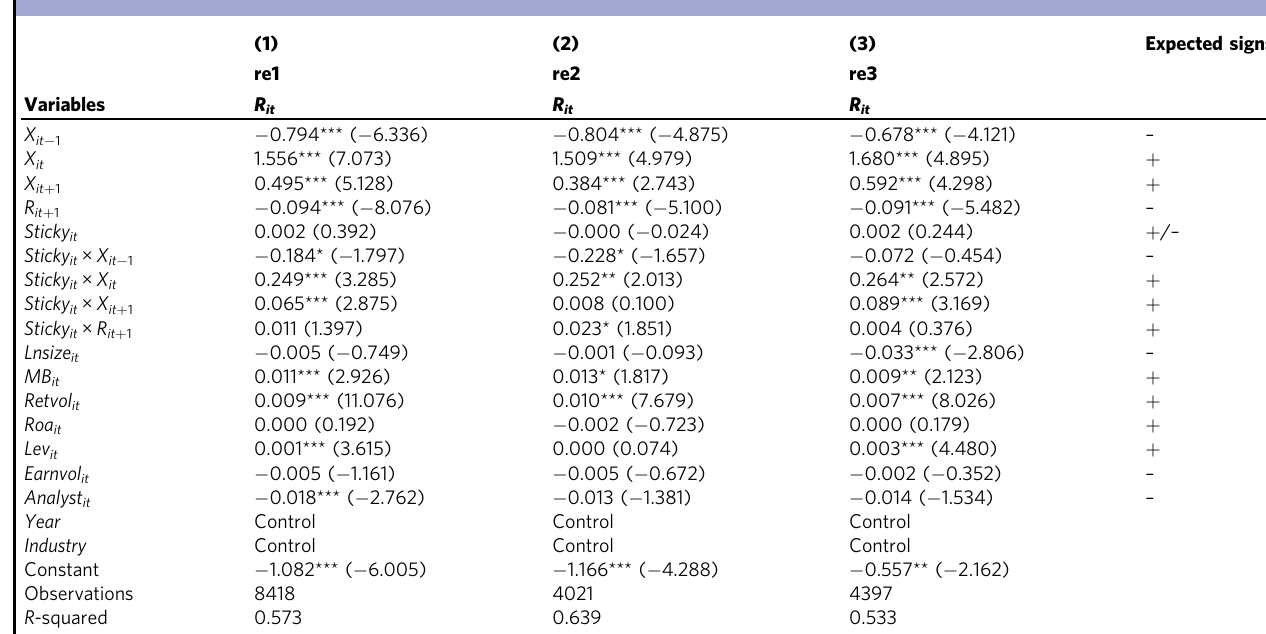
Fig. 1 Comparison of cost stickiness between state-owned and non-state- owned enterprises. Table 3 Regression table of cost stickiness and earnings response coef fi